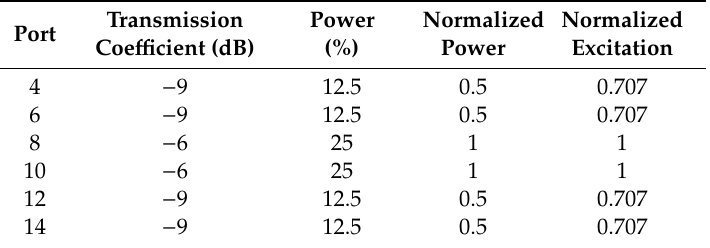
Table 2. Simulated transmission coe ffi cients, percentages of power, normalized power, and the